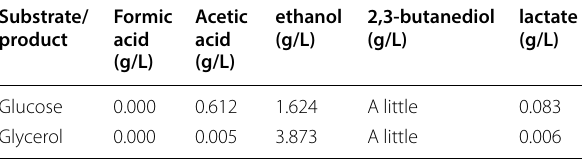
Table 3 The major liquid products and their concentrations of biohydrogen production from EB-06 fermentation of glucose and